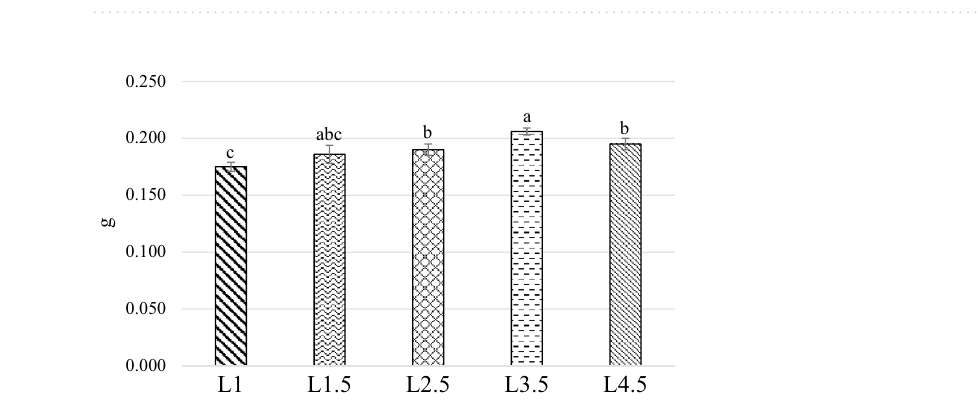
Table 2. Larvae descriptive chemical composition (g/100 g on DM) and gross energy (MJ/kg on DM) expressed on DM. L1 EE 1% diet, L1.5 EE 1.5% diet, L2.5 EE 2.5% diet, L3.5 EE 3.5% diet, L4.5 EE 4.5% diet, DM dry matter, CP crude protein, EE ether extract, GE gross energy. a Values are reported as mean of duplicate analyses.